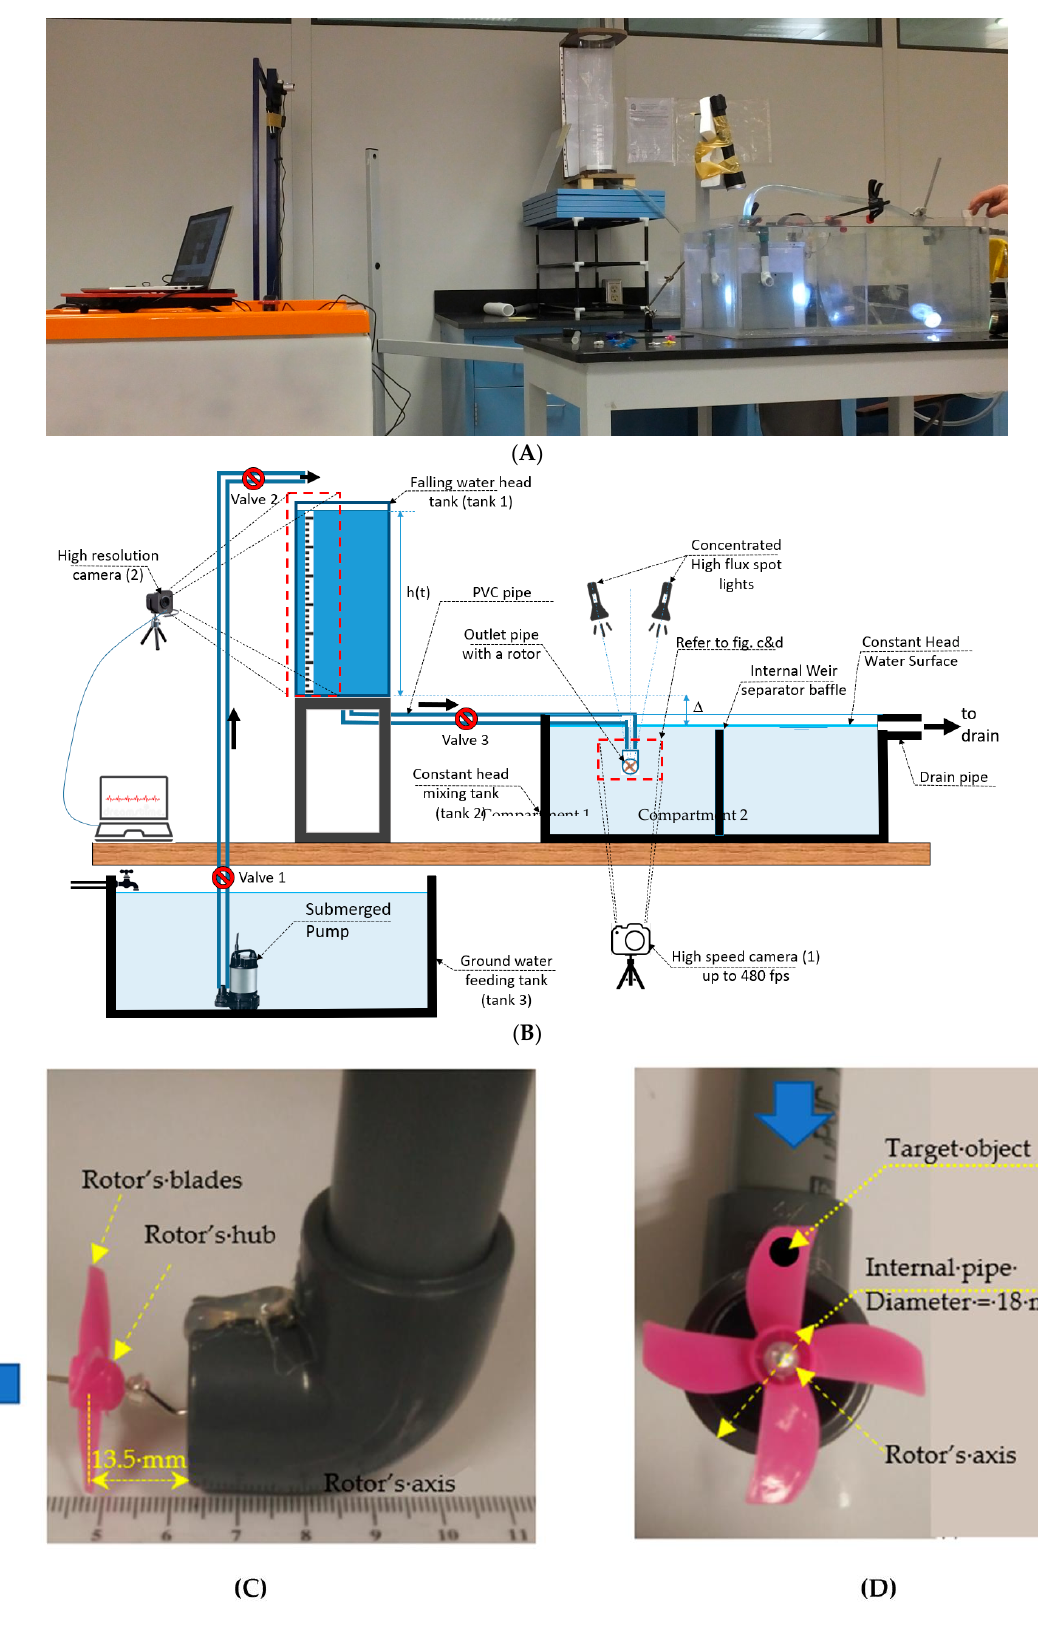
Figure 2. Experimental setup: ( A ) a snapshot of the experimental setup, ( B ) Elements of the experi- mental setup, ( C ) side view of the rotor, ( D ) front view of the